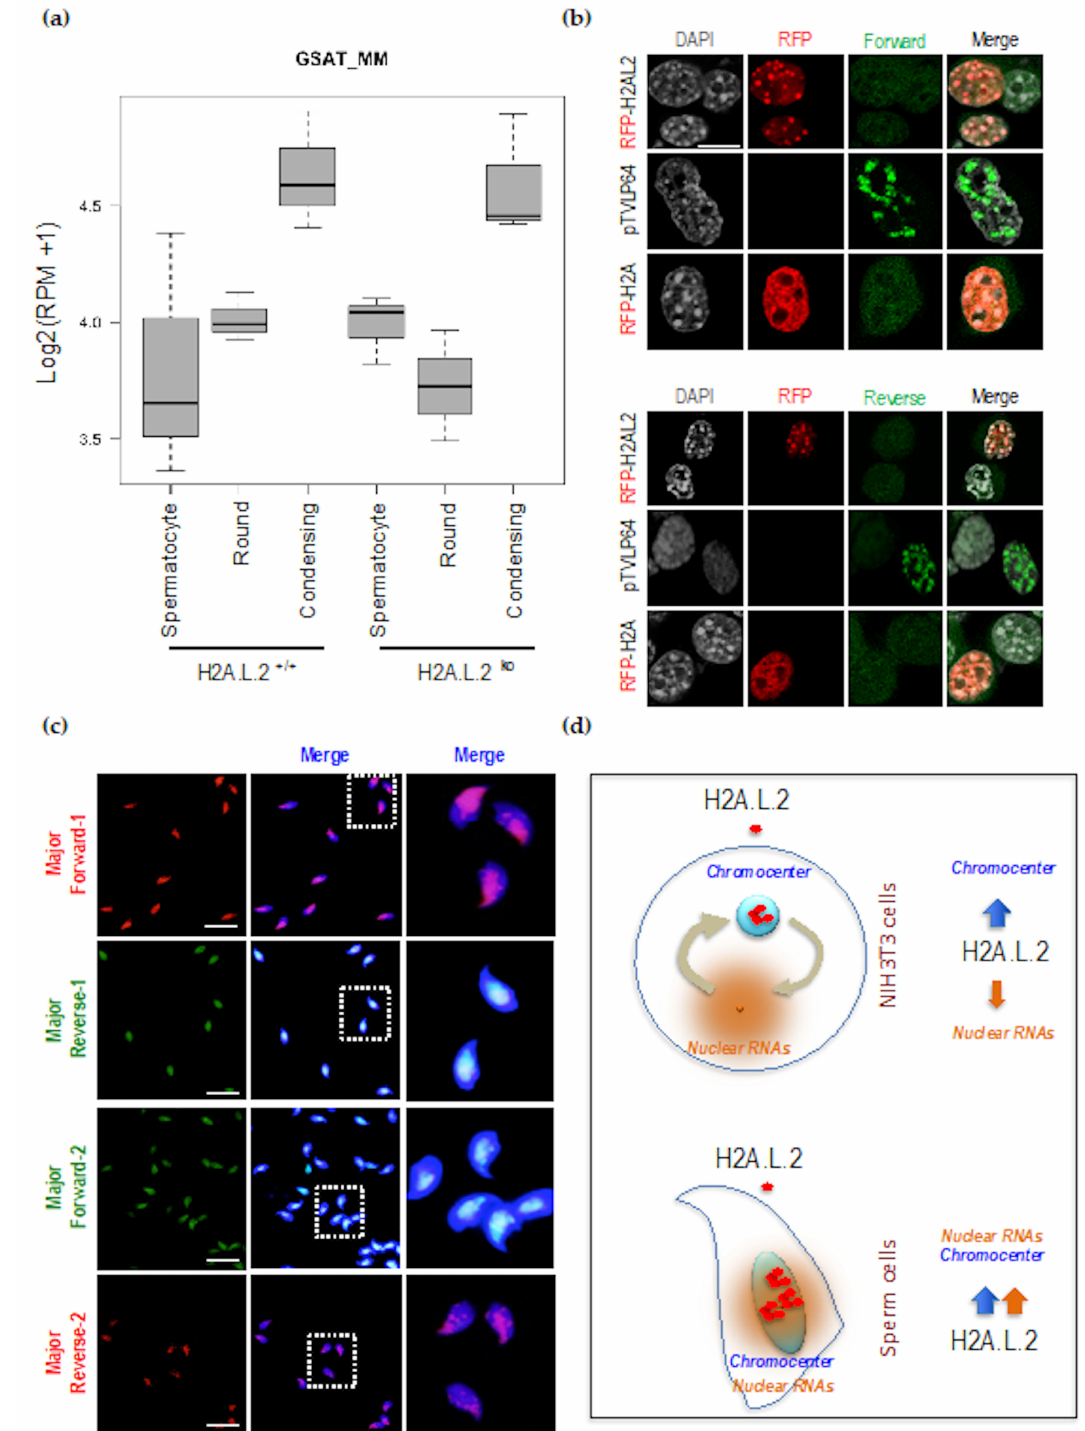
Figure 3. H2A.L.2 pericentric chromatin targeting does not induce RNA expression, but the localized expression of pericentric RNA is associated with the pericentric targeting of H2A.L.2 in spermatozoa. ( a ) Total RNAs from the indicated fractionated spermatogenic cells, spermatocytes, round and condensing spermatids, fromH2A.L.2-wildtype( +/+ )orH2A.L.2-KOmiceweresequencedandaligned. Pseudo-log of normalized read counts per million reads corresponding to major satellite sequences were plotted in a box-and-whisker fashion using R. Each box plot represents three samples of cells isolated from three di ff erent experiments. The expression of major satellite RNA was significantly increased in